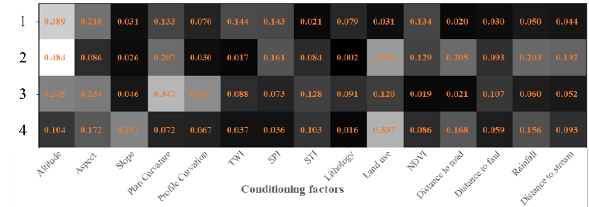
Fig. 8. Attention mechanism weights map of four